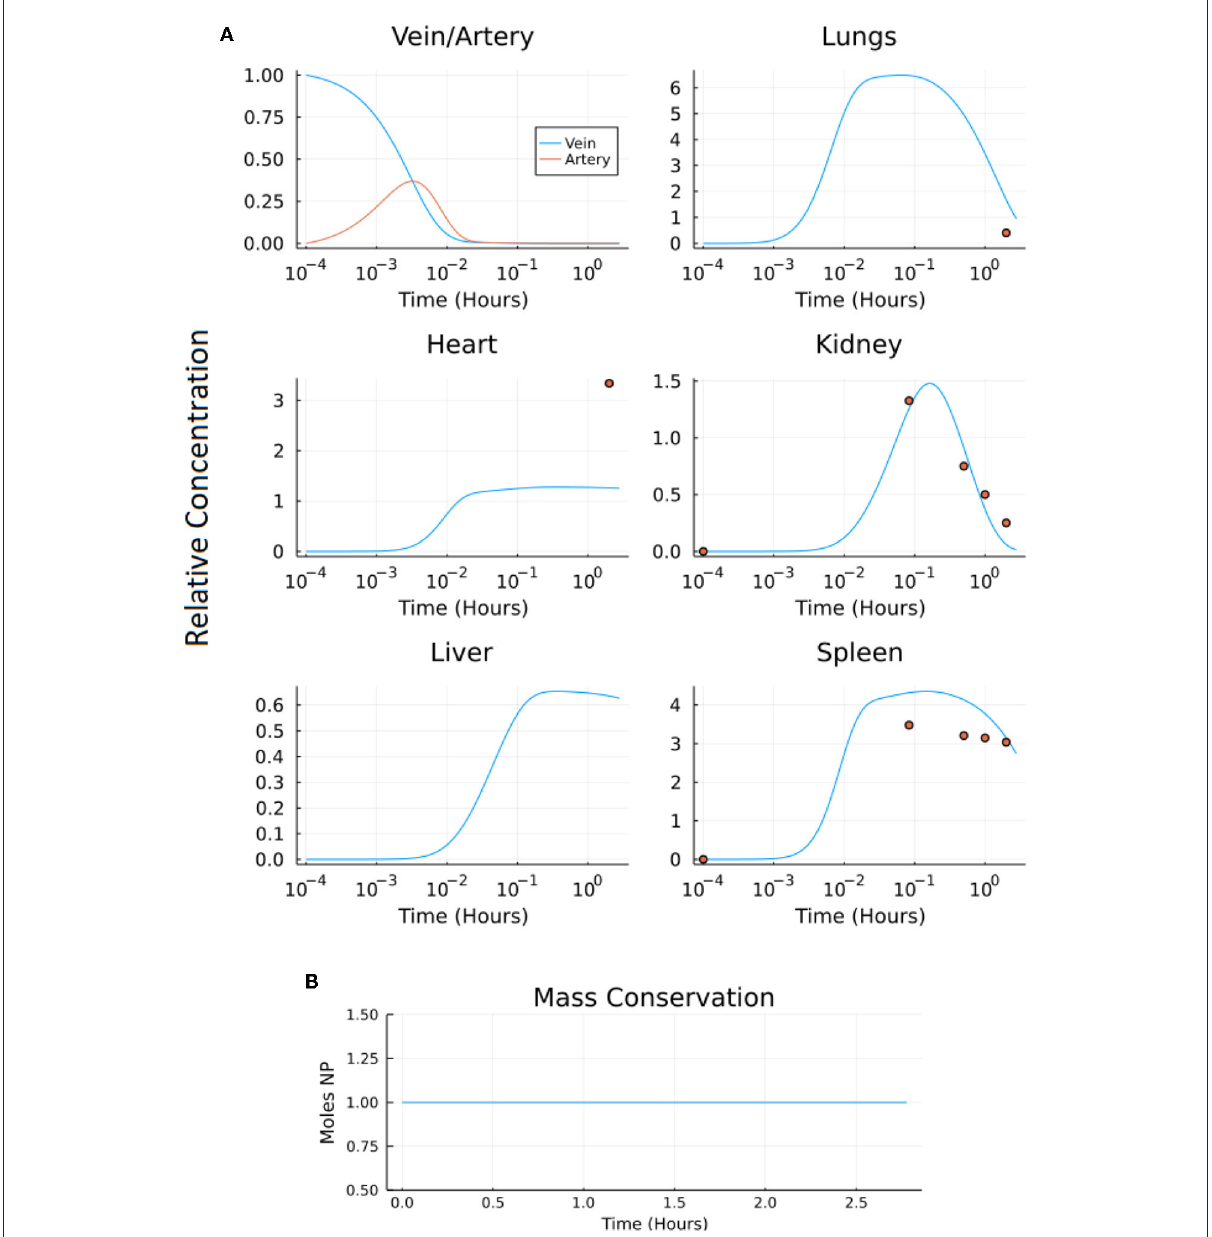
FIGURE8 Output of model A: (A) the normalized concentration of NP in each of the five organ compartments and the arteries and veins of the original model, and (B) the conservation figure.